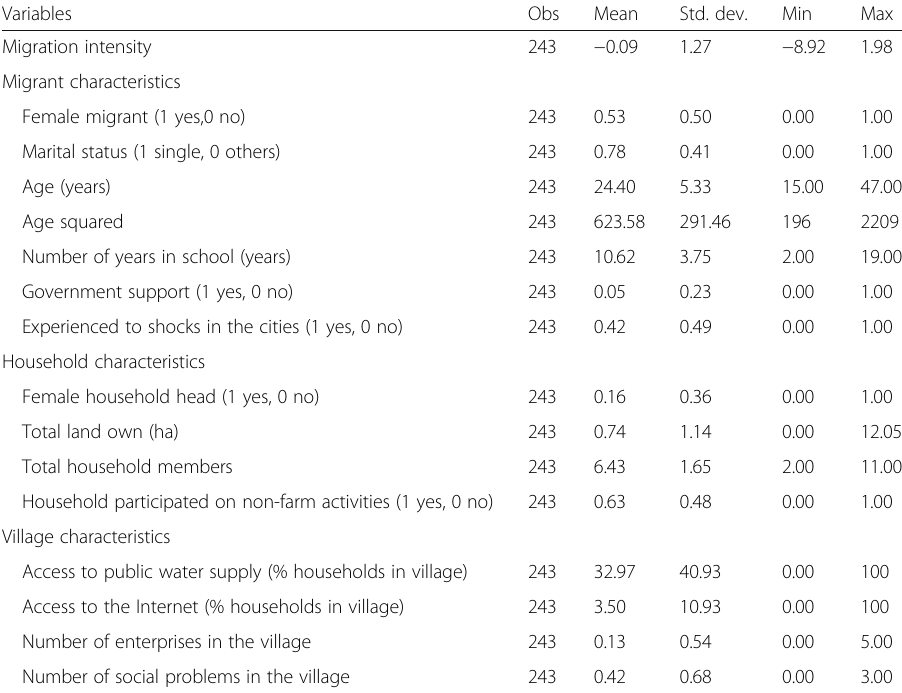
Number of social problems in the village